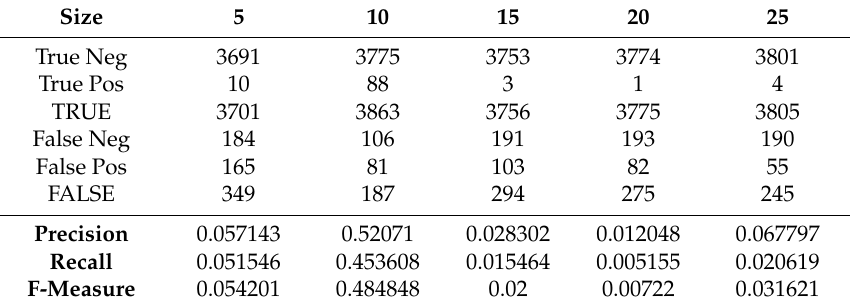
Table 4. Results of LSA output processing with the binary method.